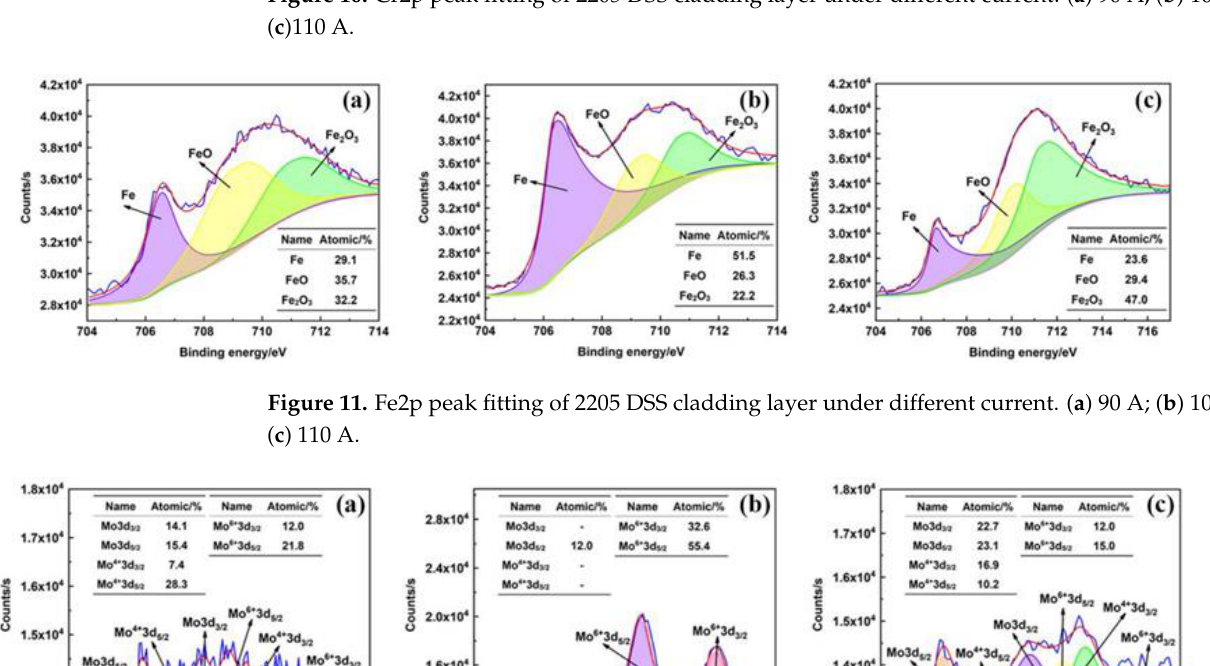
Figure 11. Fe2p peak fitting of 2205 DSS cladding layer under different current. ( a ) 90 A; ( b ) 100 A; ( c ) 110 A.